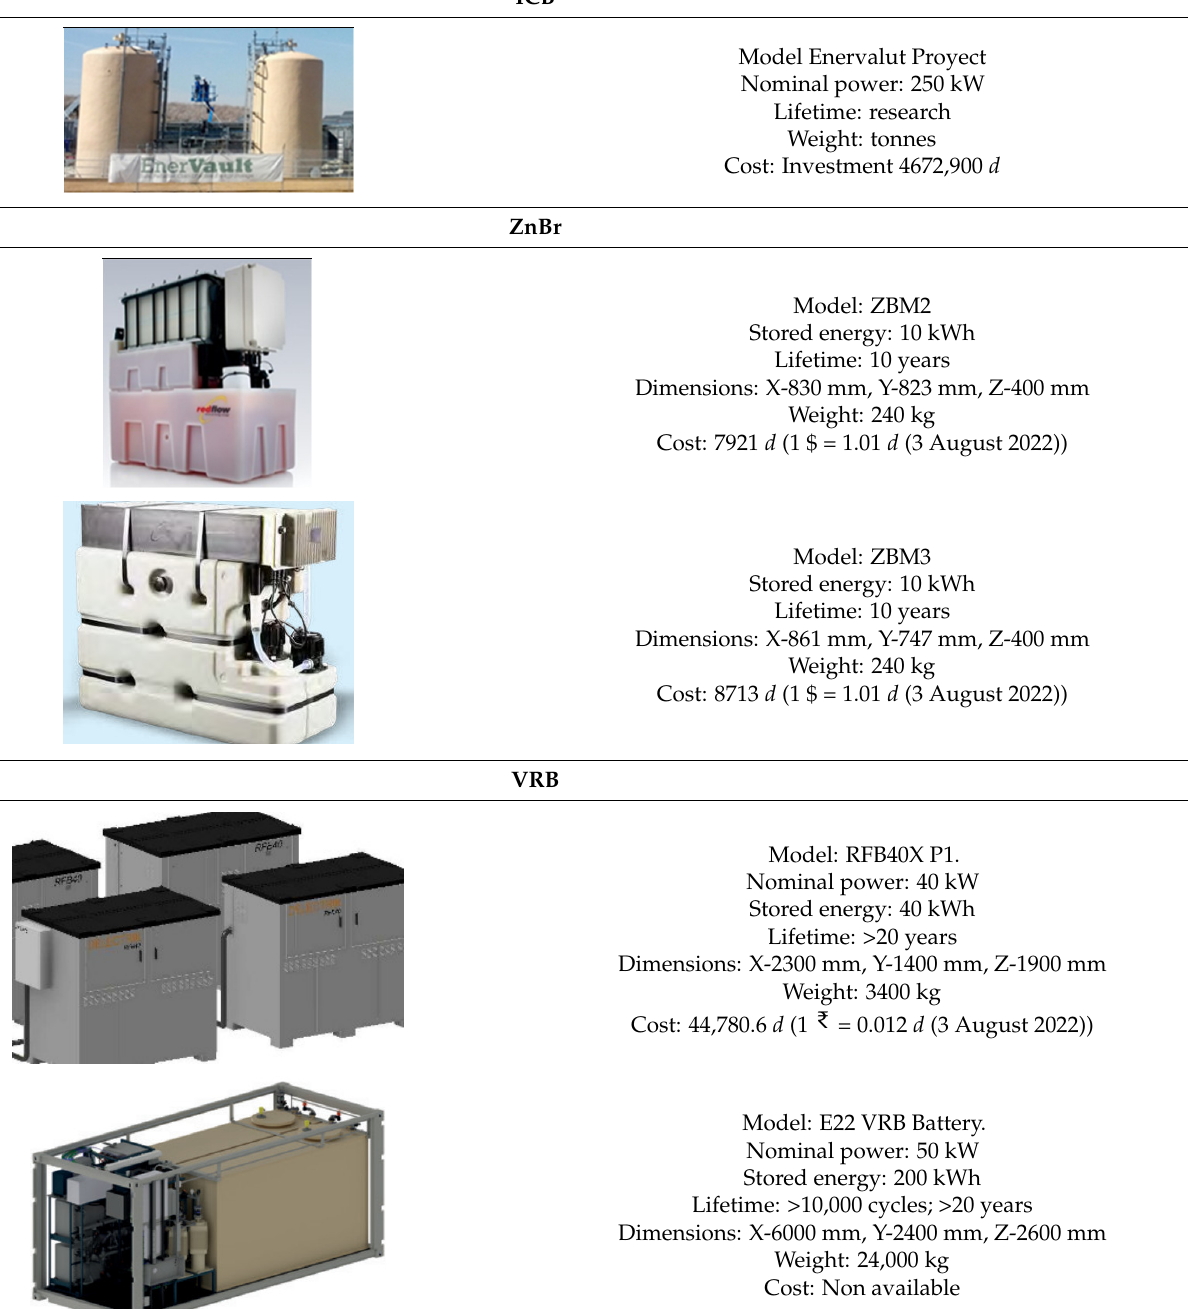
Table A3. Commercial examples of Redox Flow Batteries. Data provided by the manufacturer.